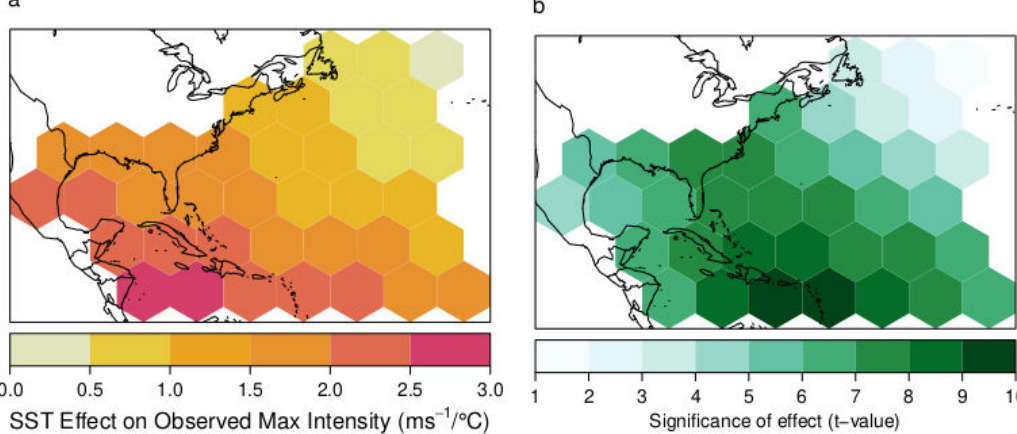
Figure 6. ( a ) Strength of the local relationship between the observed per event maximum wind intensity and the average (“normal”) August–October SST in ◦ C. ( b ) Significance of the